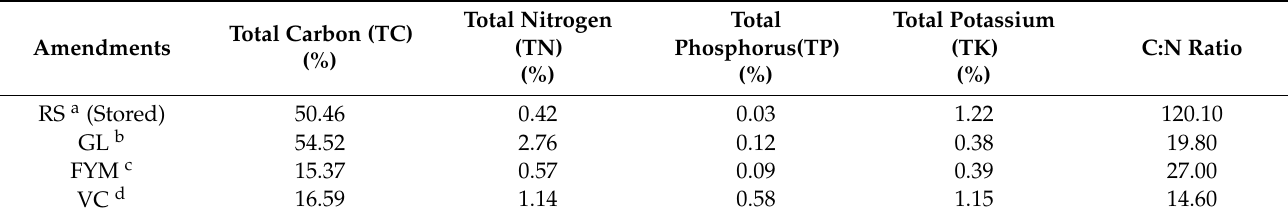
Figure 1. Layout of experimental plots in the field and treatment allocation channels. The numbers within the plots indicate the treatments: 1 indicates T 1 , control (no fertilizer or manure); 2 indicates T 2 , rice straw + NPK (nitrogen, phosphorus, potassium) as chemical fertilizer; 3 indicates T 3 , Gliricidia leaves + NPK as chemical fertilizer; 4 indicates T 4 , farmyard manure (FYM) + NPK as chemical fertilizer; 5 indicates T 5 , Vermicompost + NPK as chemical fertilizer; 6 indicates T 6 , only chemical fertilizers. Table 2. Nutrient contents and carbon/nitrogen (C/N) ratios for the organic